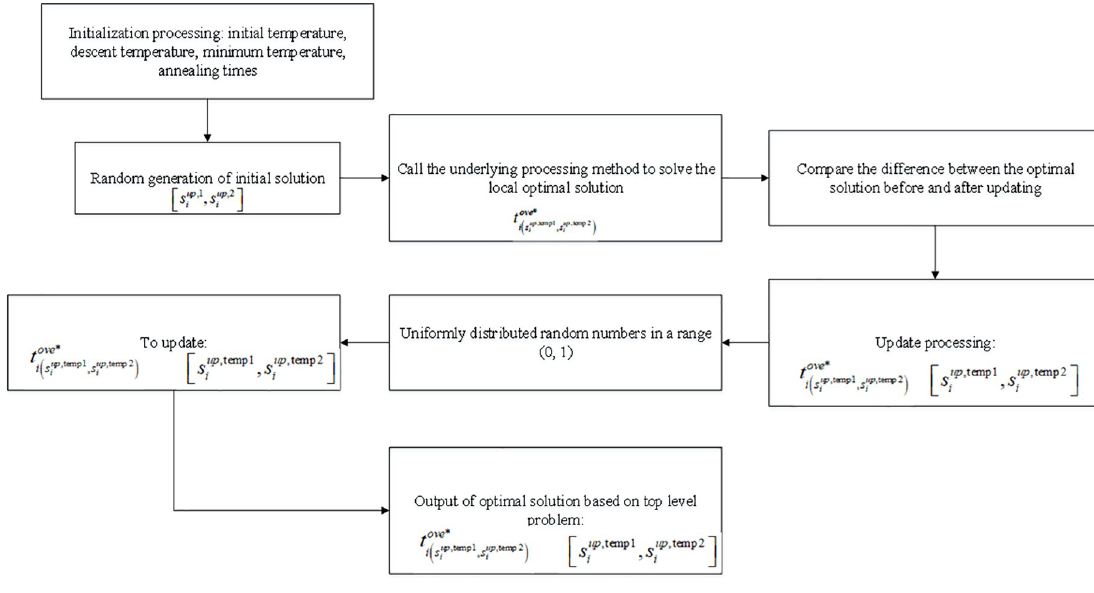
Fig 4. Implementation process of